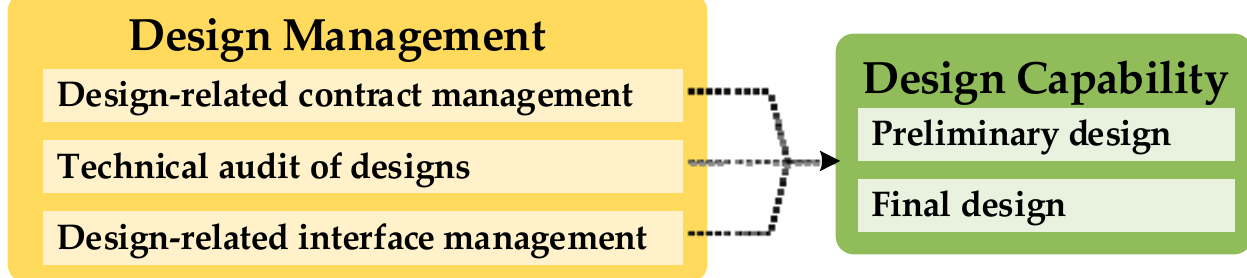
Figure 5. Relationship between design management and design capability.